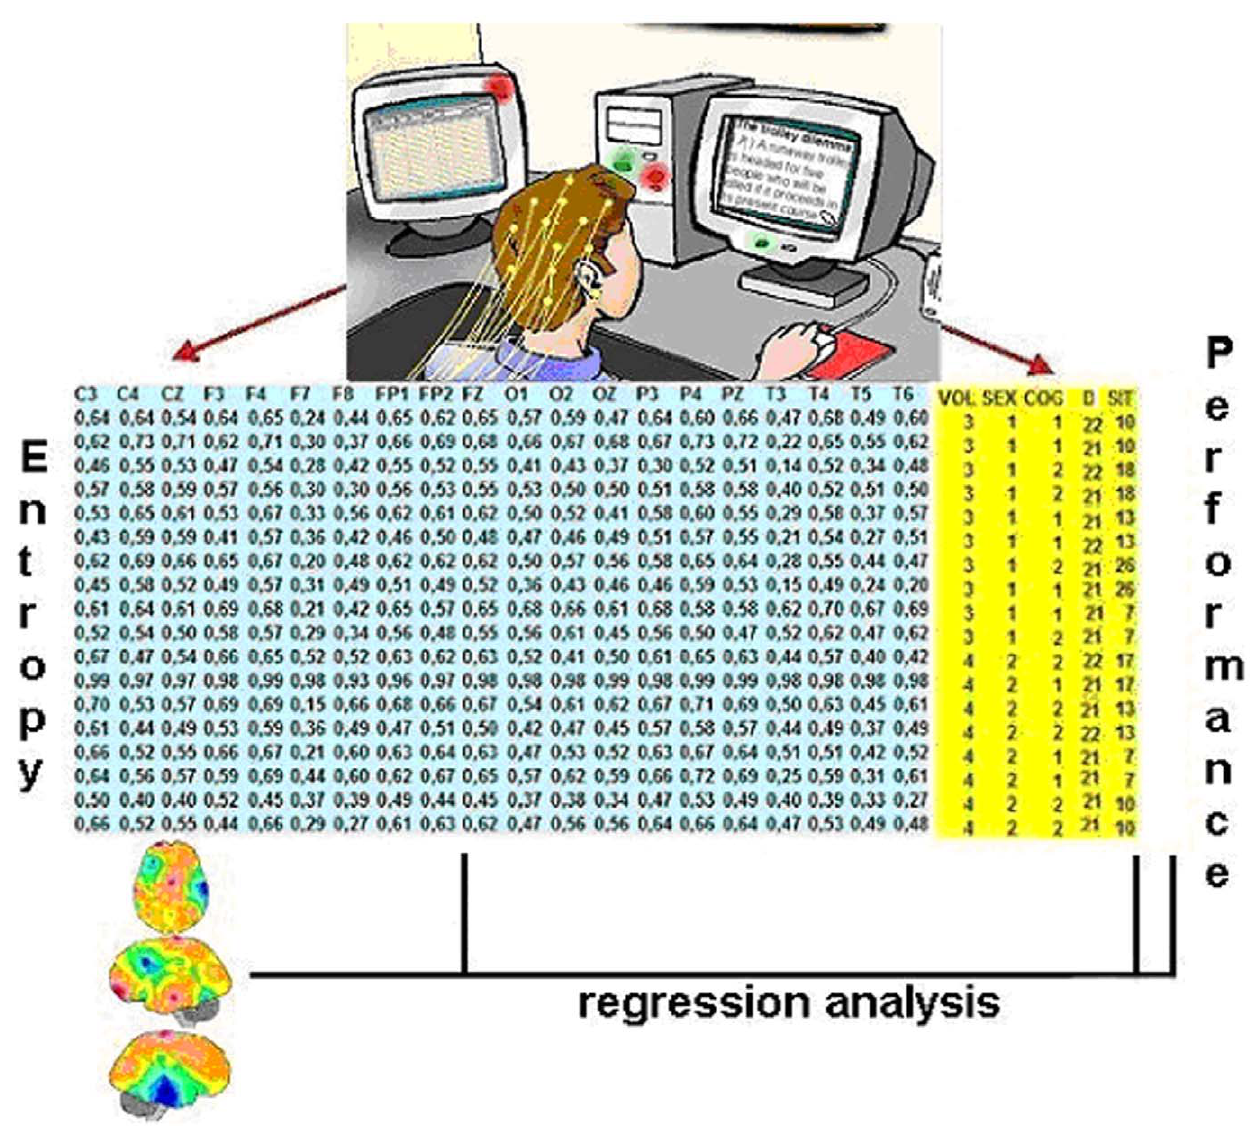
Figure 7. The experiment. Two networked microcomputers were used to record the EEG activity (10/20 system) while the individual is solving a specific cognitive task. The beginning of each task and the moment a decision is made are saved in the database together with the type of decision- making (D) and time required (response time ST) to achieve such decision. The linear correlation coefficients r i,j for the recorded activity at each recording electrode e i , with reference to the recorded activity for each other 19 recording sites e j , were calculated for each game (COG) performed by a given subject. These r i,j were used to calculate the correlation entropy h(e i ) for each recording electrode e i . In this way, h(e i ) was calculated for all 20 recoding electrodes. The corresponding values of h(e i ) constitute the Entropy Data Base. Regression analysis between RT and h(e i ) was used to build the cognitive mapping. Each mapping shows the contribution b i h m (e i ) of each electrode e i to ST. h m (e i ) is the average of h(e i ) calculated for all subjects. IQs values of each subject were added to each corresponding data base record.